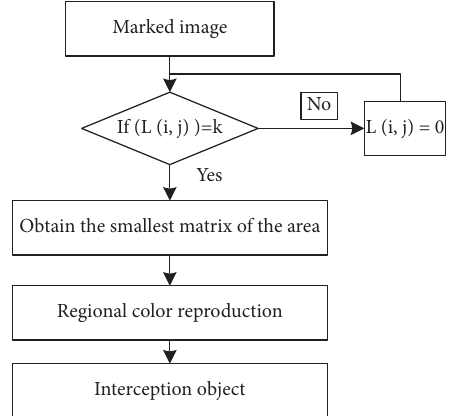
Figure 10: The minimum matrix interception